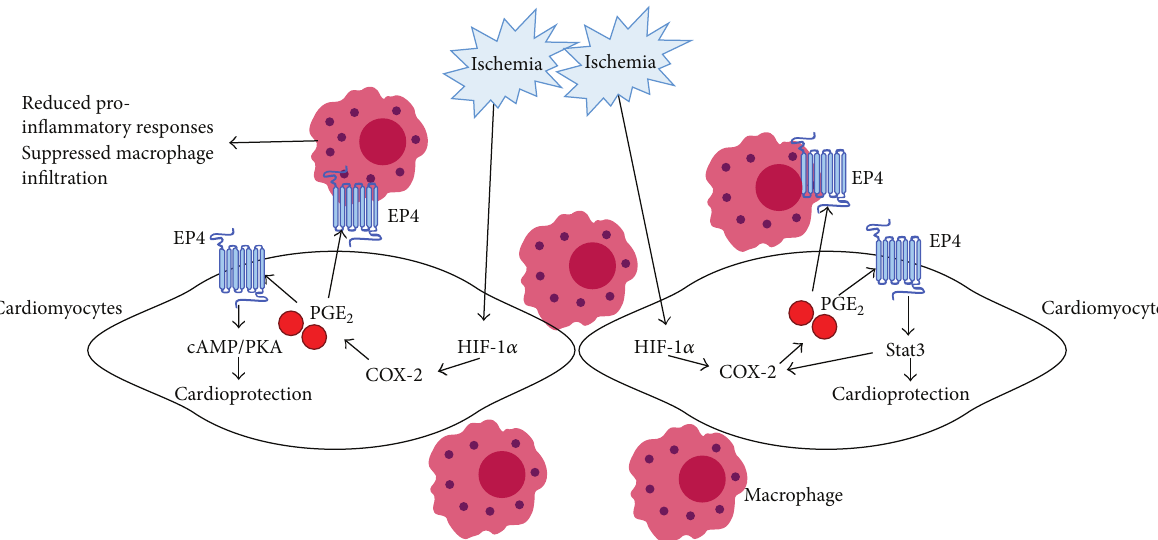
Figure 2: Schematic representation of the proposed role of EP4-mediated signaling under myocardial ischemia. During cardiac ischemia, increased PGE 2 level may be a consequence of increased hypoxia inducible factor- (HIF-) 1 𝛼 /cyclooxygenase-2 (COX-2) activation. PGE 2 may play a beneficial role in cardiac ischemia/reperfusion injury through EP4/cyclic adenosine monophosphate (cAMP)/protein kinase A (PKA) or EP4/signal transducer and activator of transcription 3 (Stat3) signaling pathway. In addition, synthesized PGE 2 in cardiomyocytes also diffuses into adjacent infiltrated macrophages or other inflammatory cells, protects the heart from ischemia/reperfusion injury through binding with EP4 receptor, and exerts anti-inflammatory